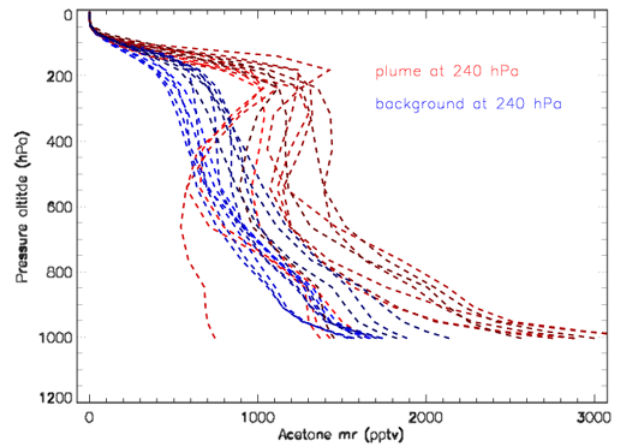
Fig. 6. Temporal and horizontal variability of acetone vmr (pptv) at 238hPa over South Asia. Daily averages are provided by LMDz- INCA. The dashed line represents the regional average, with the shaded zone for ± 1 standard deviation. Full lines show spatial min- imum and maximum acetone vmr for each day. Monthly number of values larger than 1000pptv is indicated at the top of the figure.